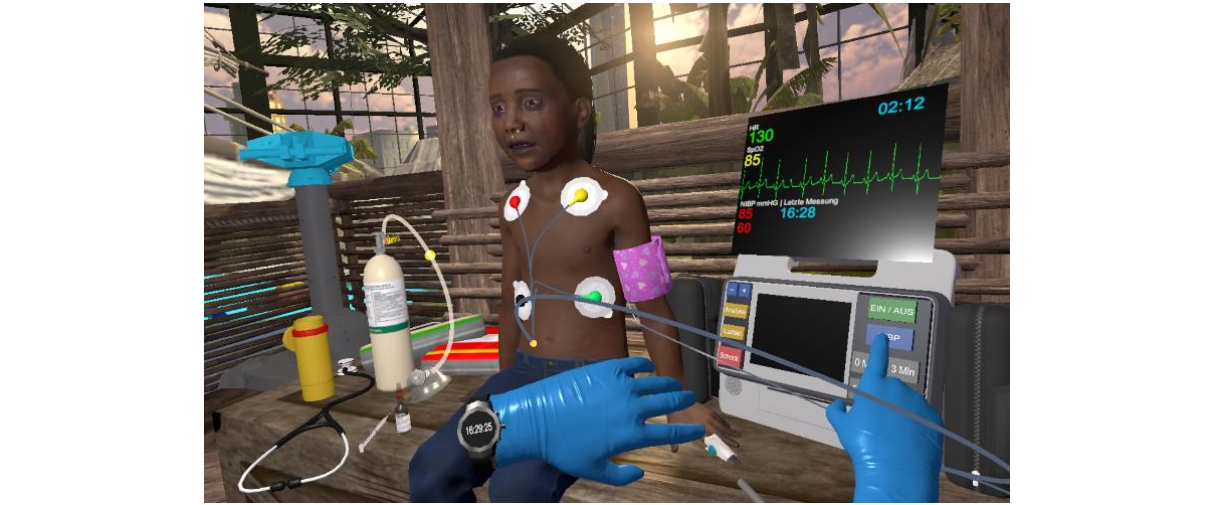
Figure 2. The virtual patient in the virtual